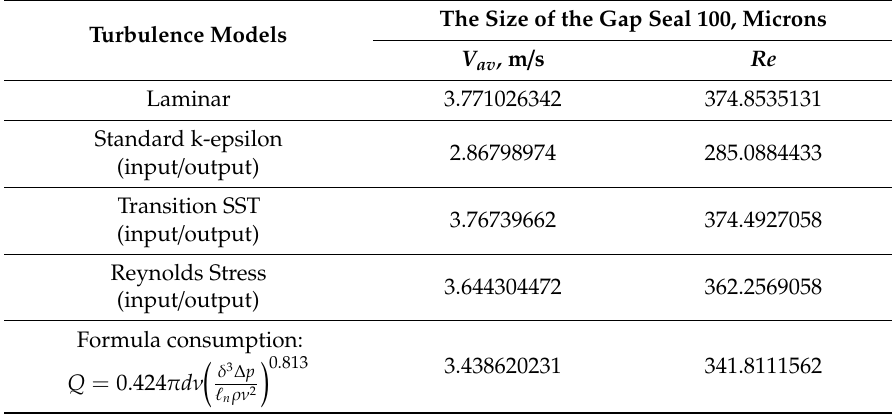
Table 8. Values of average velocities and Reynolds numbers during fluid flow in a step-type gap seals in the reverse direction determined by di ff erent flow